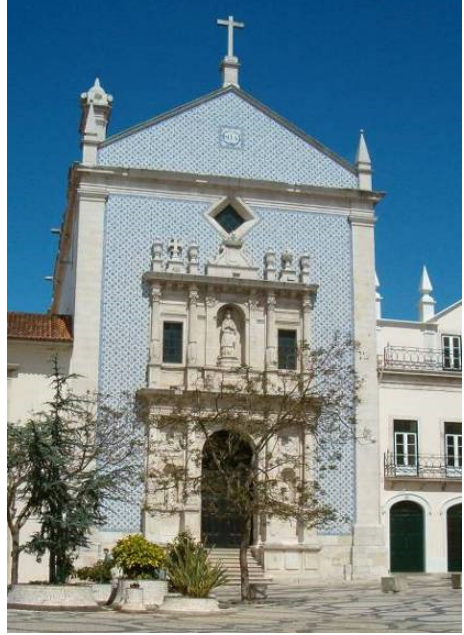
Appl. Sci. 2022 , 12 , x FOR PEER REVIEW Figure 2. Main elevation of the church. Figure 2. Main elevation of the church.